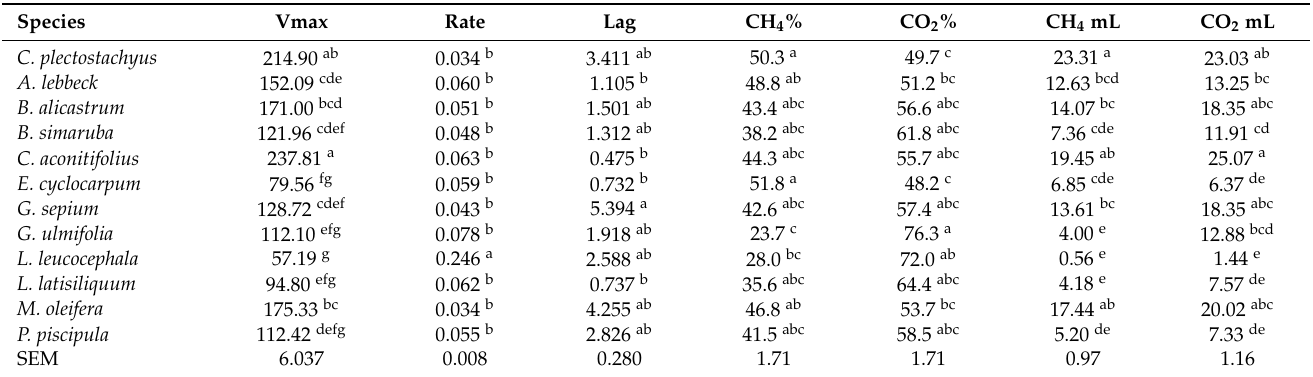
Table 4. Kinetics parameters from fitted curves and production of methane (CH 4 ) and carbon dioxide (CO 2 ) of the foliage of tropical trees and shrubs in ruminal fermentation in vitro.